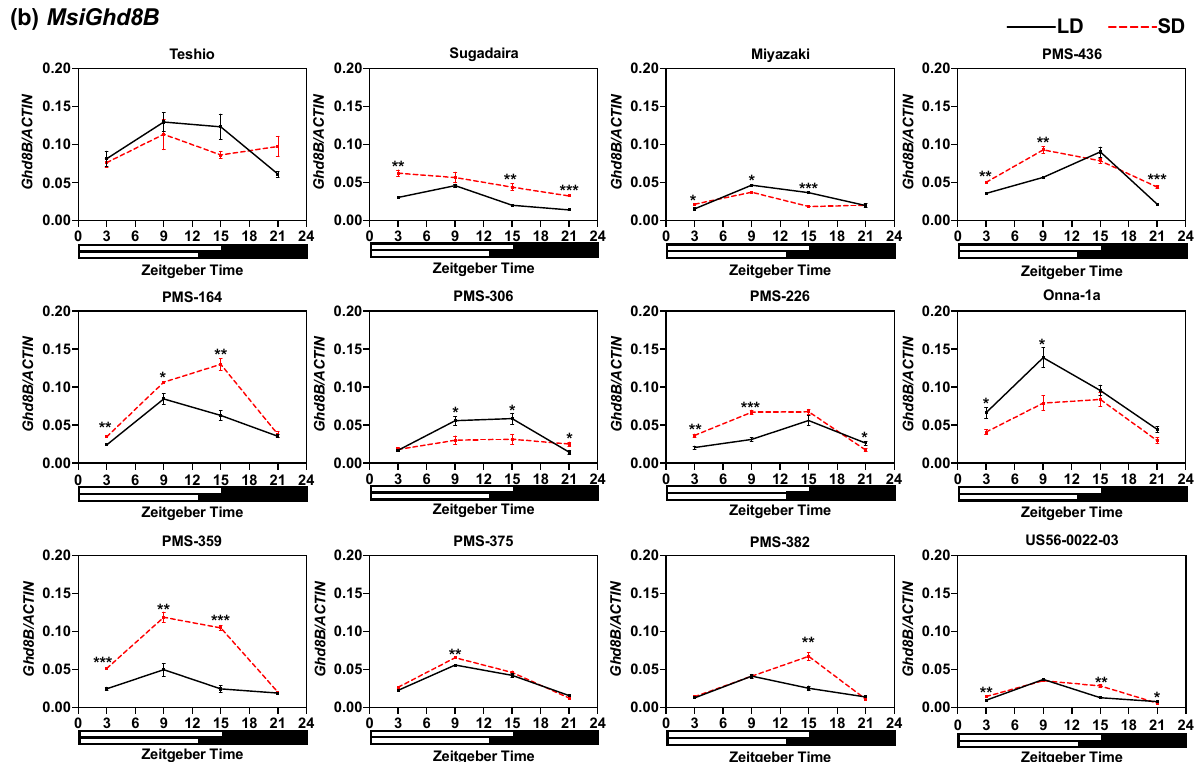
Figure 5. Diurnal expression of MsiGhd8 in 12 Miscanthus sinensis genotypes under long days (15 h, long-day (LD); solid black lines) and short days (12.5 h, short-day (SD); red dashed line). ( a ) MsiGhd8A and ( b ) MsiGhd8B . Relative mRNA levels are expressed as the ratios to ACTIN transcript levels. The numbers below the x-axis indicate Zeitgeber times (ZT) of the day. The white bar at the bottom of each graph indicates the light period and the black bar indicates the dark period. Mean ± 1SE for three replications are given for each data point. Asterisks indicate significant difference between the two means under LD and SD at the same ZT of the day (Student’s t -test, * p < 0.05, ** p < 0.01, *** p < 0.001). No asterisk indicates the difference between the two means is not statistically significant ( p <